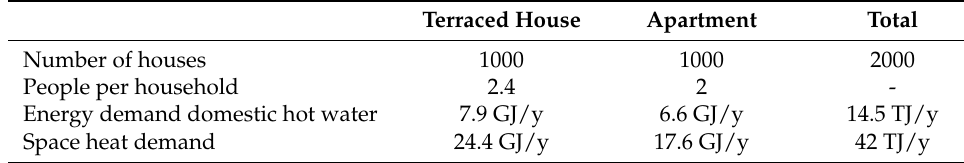
Table 2. Neighbourhood energy demand